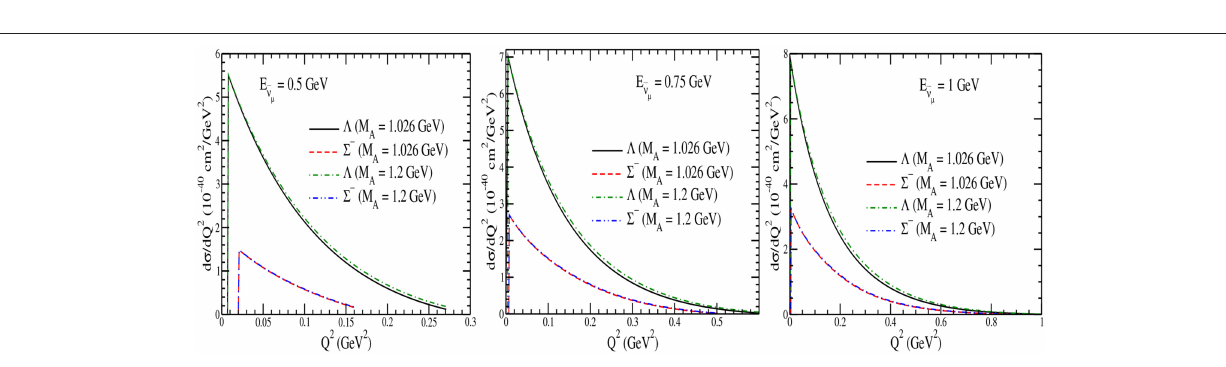
ν µ = 0.5 GeV (left) , 0.75 GeV (middle) , and 1 ¯